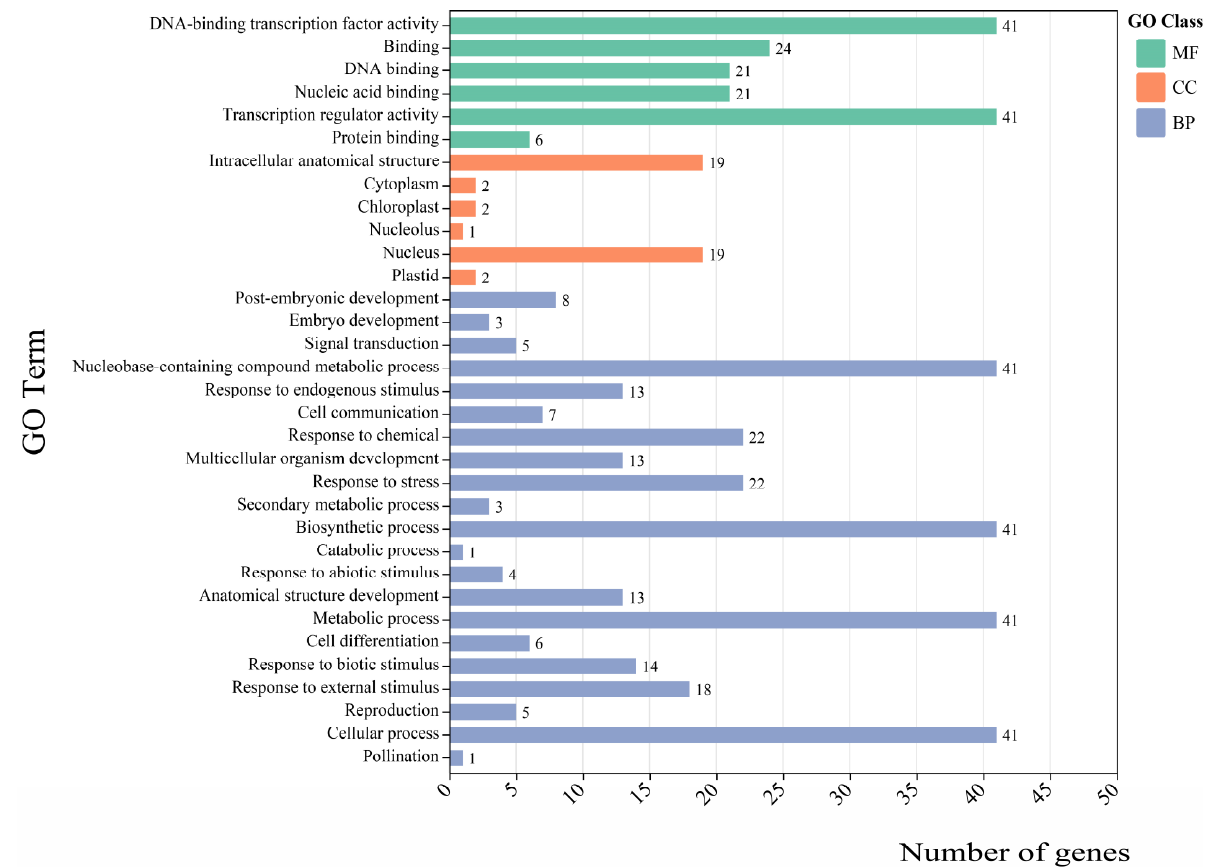
Figure 7. GO annotation results of CsWRKY genes GO-Level 3. The results were divided into three major categories: molecular functions, cellular components, and biological processes, shown in green, yellow and blue, respectively. The x -axis indicates gene functions, and the y -axis indicates the partial GO Term.